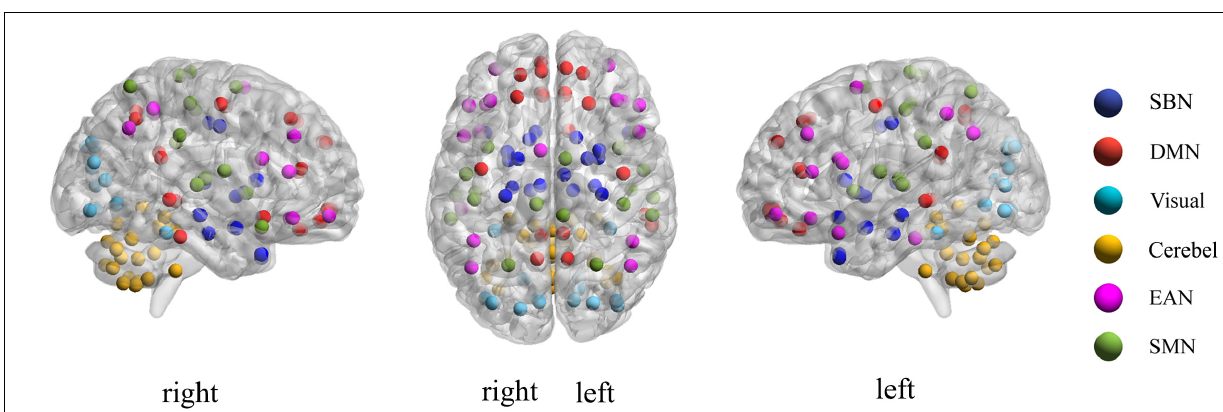
FIGURE 2 | The pipeline of the “hierarchical sub-network method.”